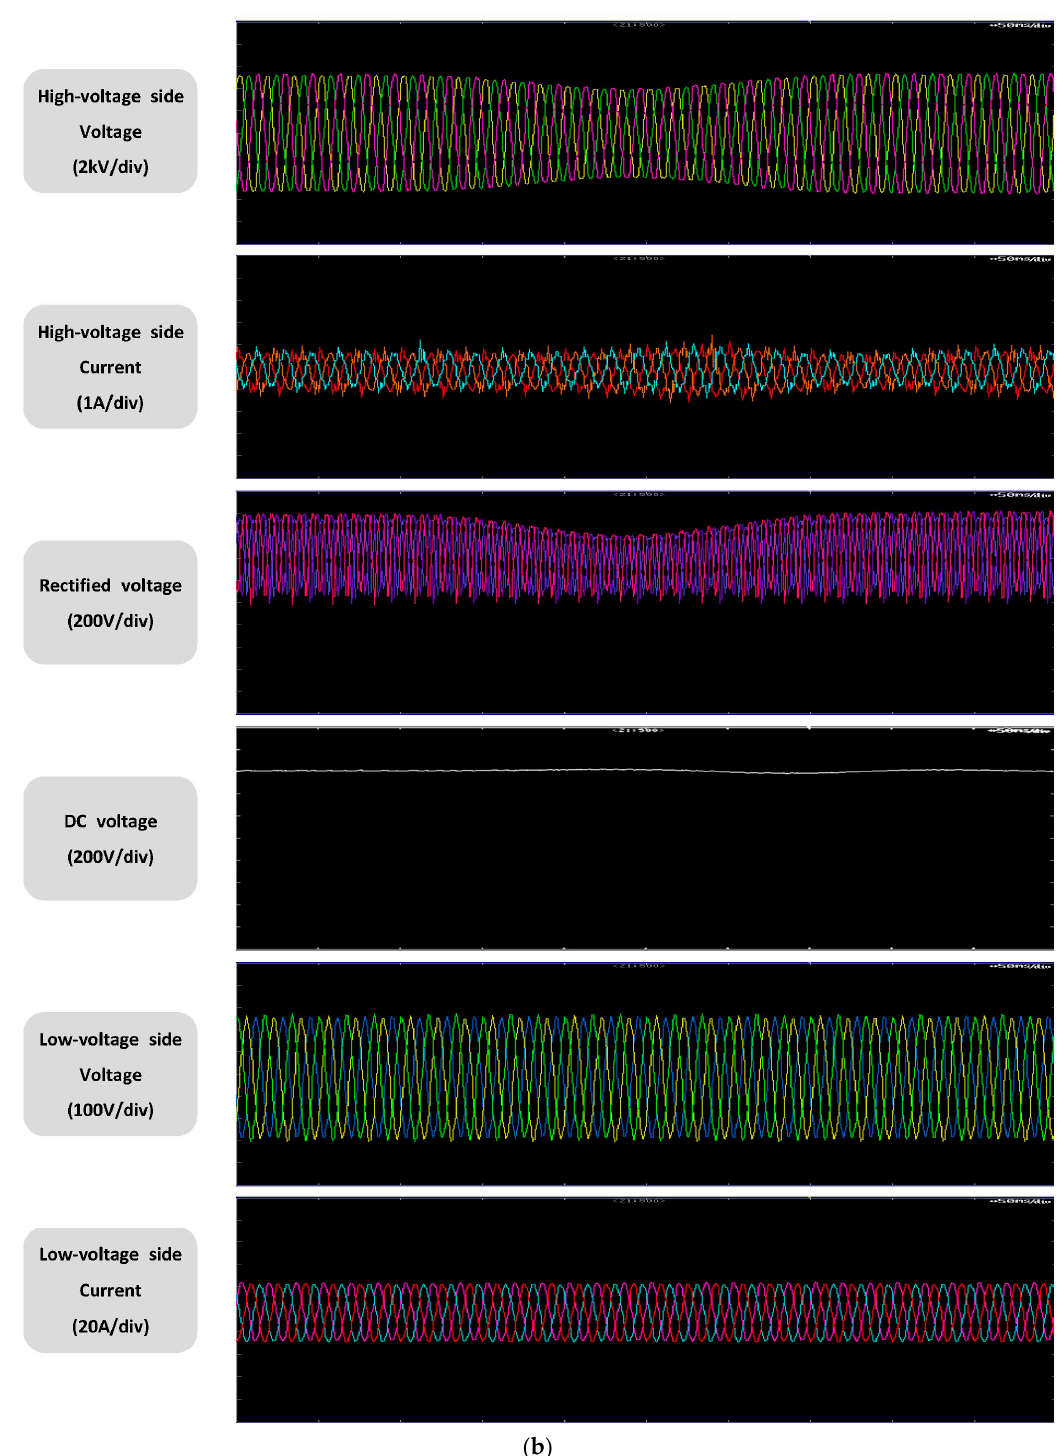
Figure 13. Experimental results in input voltage sag: ( a ) forward power flow; ( b ) reverse power flow.